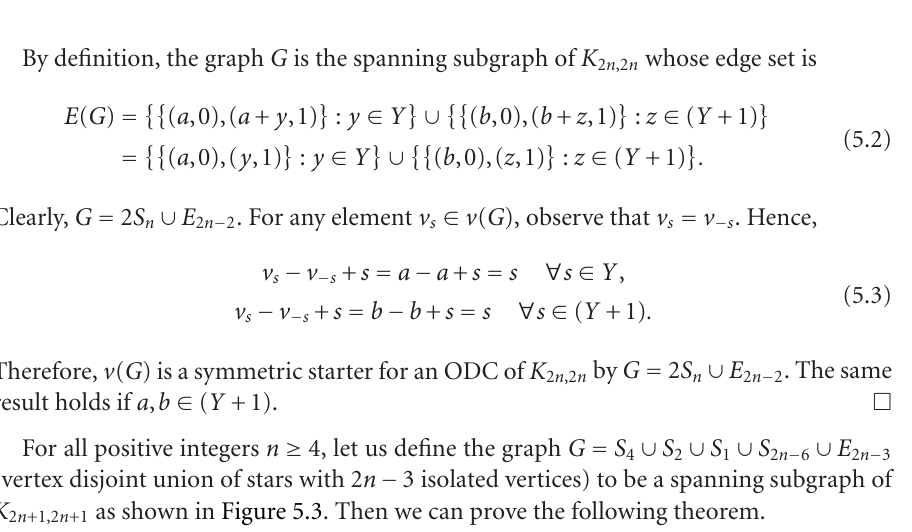
Figure 5.3. Symmetric starter of an ODC of K 2 n +1,2 n +1 by G = S 4 ∪ S 2 ∪ S 1 ∪ S 2 n − 6 ∪ E 2 n − 3 with respect to Z 2 n +1